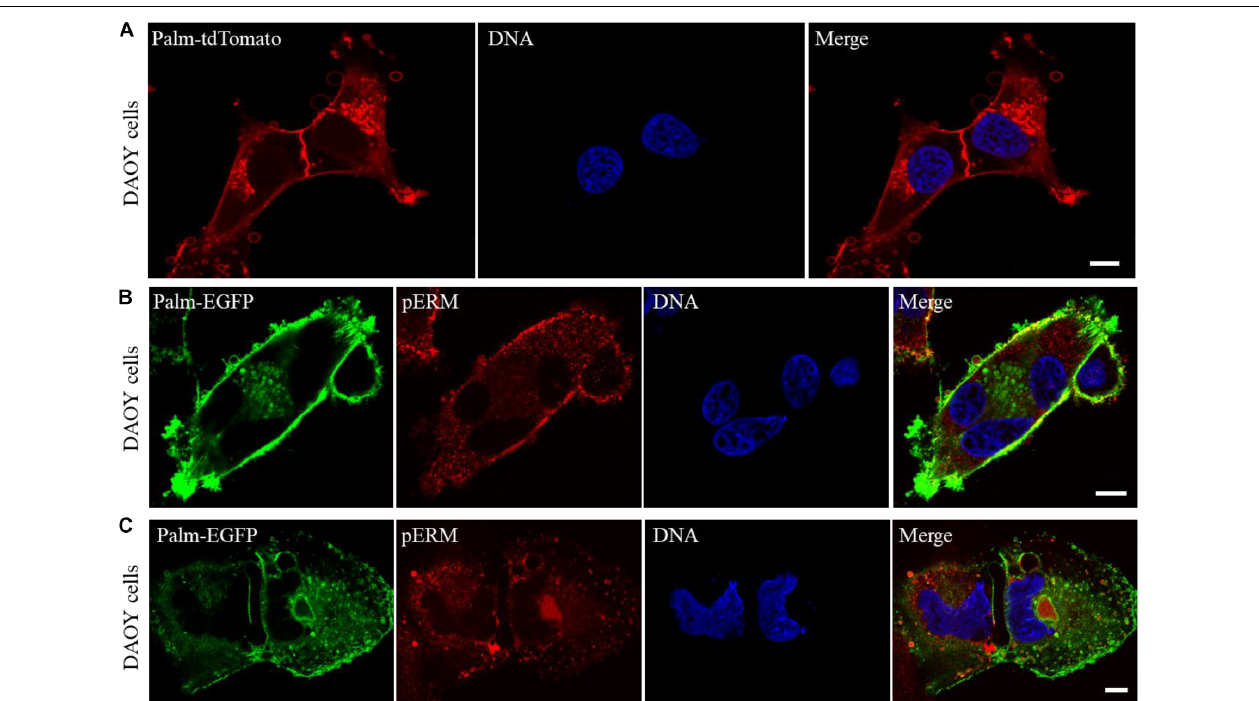
FIGURE 4 | DAOY cells release a large number of vesicles that are loaded with pERM proteins, which may facilitate cell fusion and invasions. Confocal microscope examination of DAOY cells expressing a membrane-targeted Palm-tdTomato reporter shows extensive number of vesicles that surround the cells in varying sizes. Scale bar, 10 µ m (A) . Interaction of plasma membranes during cell fusion was visualized in Palm-EGFP expressing DAOY cells after immuno-staining with a pERM antibody. Scale bar, 10 µ m (B,C) . Note that the majority of both intracellular and extracellular vesicles of DAOY cells are loaded with pERM proteins (B,C)